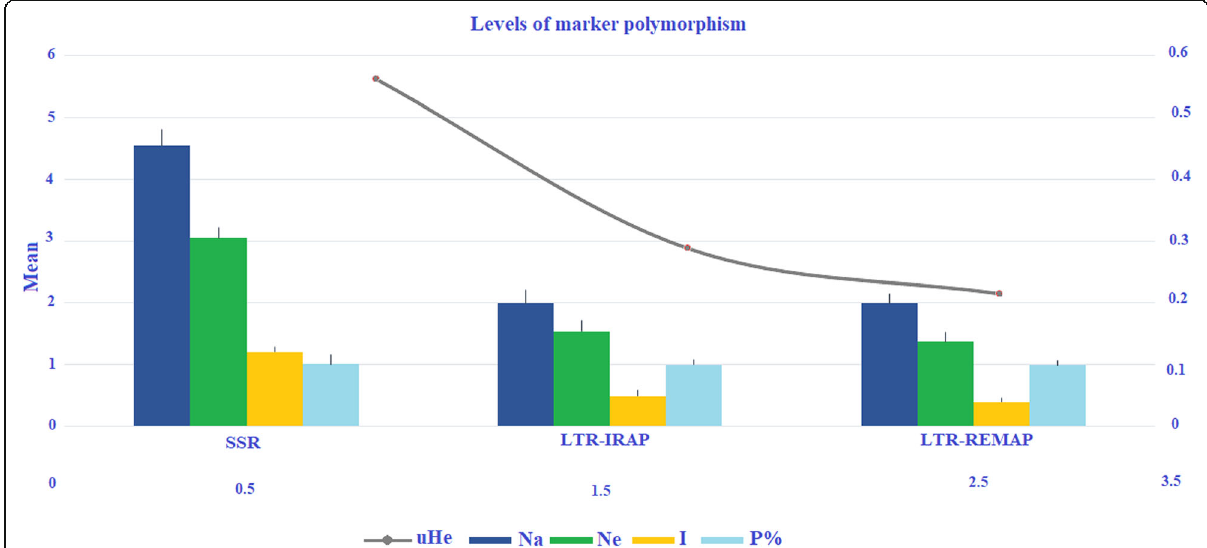
Fig. 2 Schematic representation the comparison information obtained of the levels of polymorphism in SSR, LTR-IRAP, and LTR-REMAP markers within 20 genotypes of citrus and its relatives species